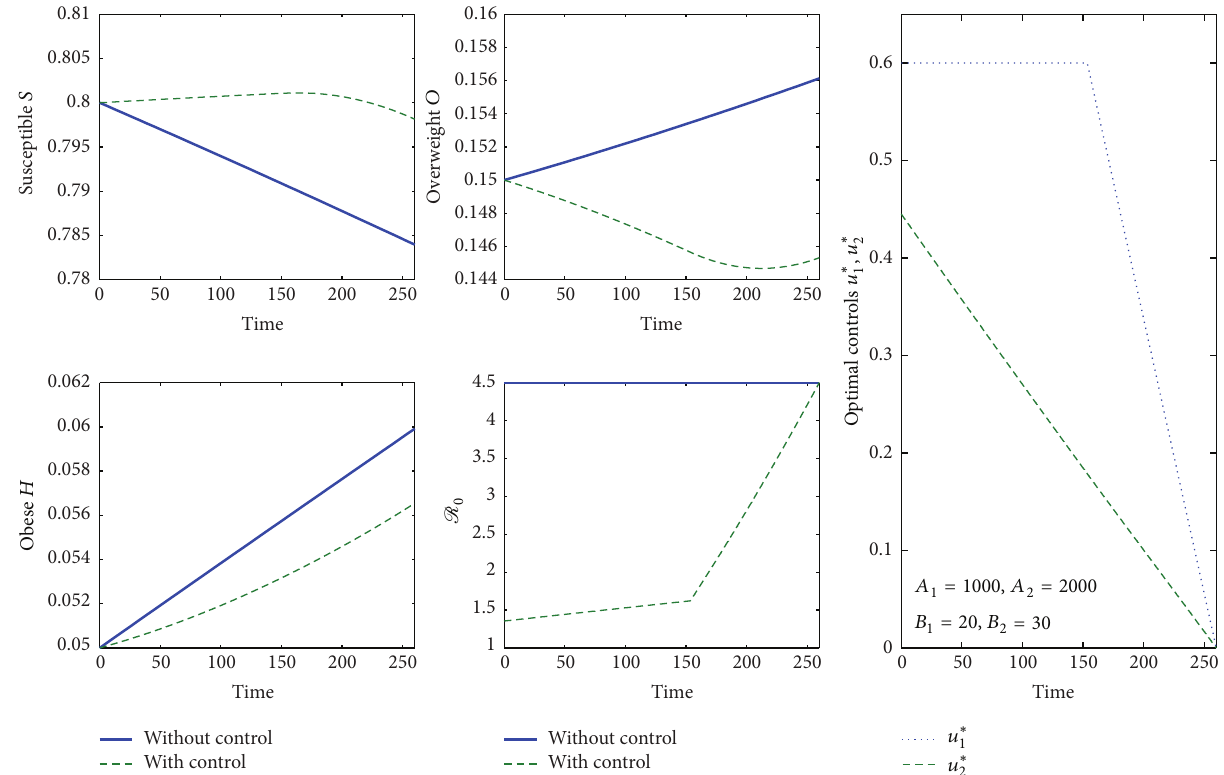
Figure 3: Implementation of optimal control and corresponding state of the system with initial condition 𝑆( 0 ) = 0 . 8, 𝑂( 0 ) = 0 . 15, and 𝐻( 0 ) = 0 . 05.